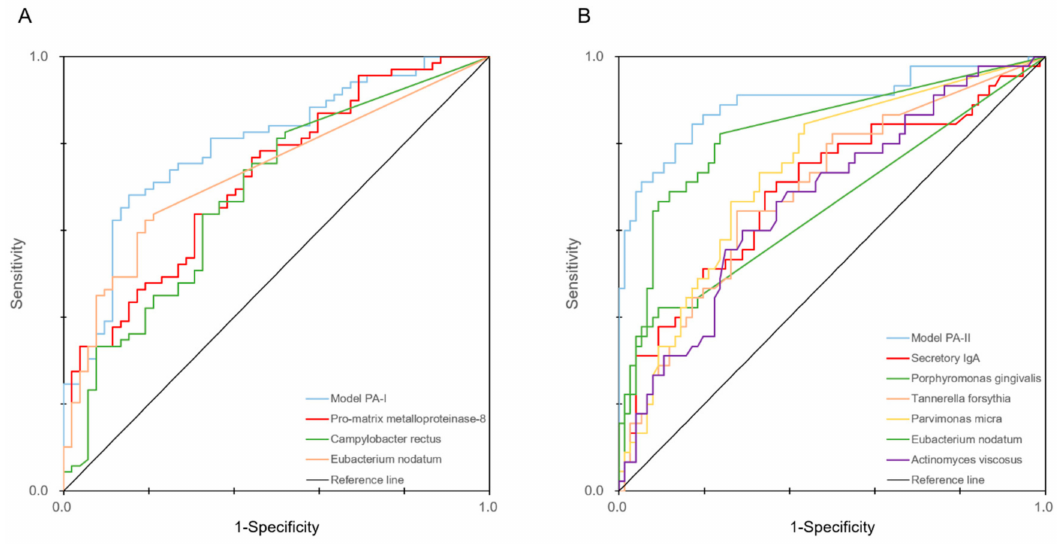
Figure 3. ROC curves of the PA-I ( A ) and PA-II ( B ) models. The ROC curves of the biomarkers that were significantly related and included in each model are also included in each